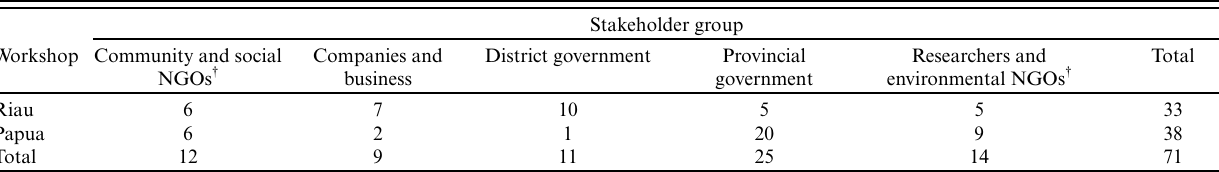
Table 1. Stakeholder groups and numbers of participants involved in the workshops.